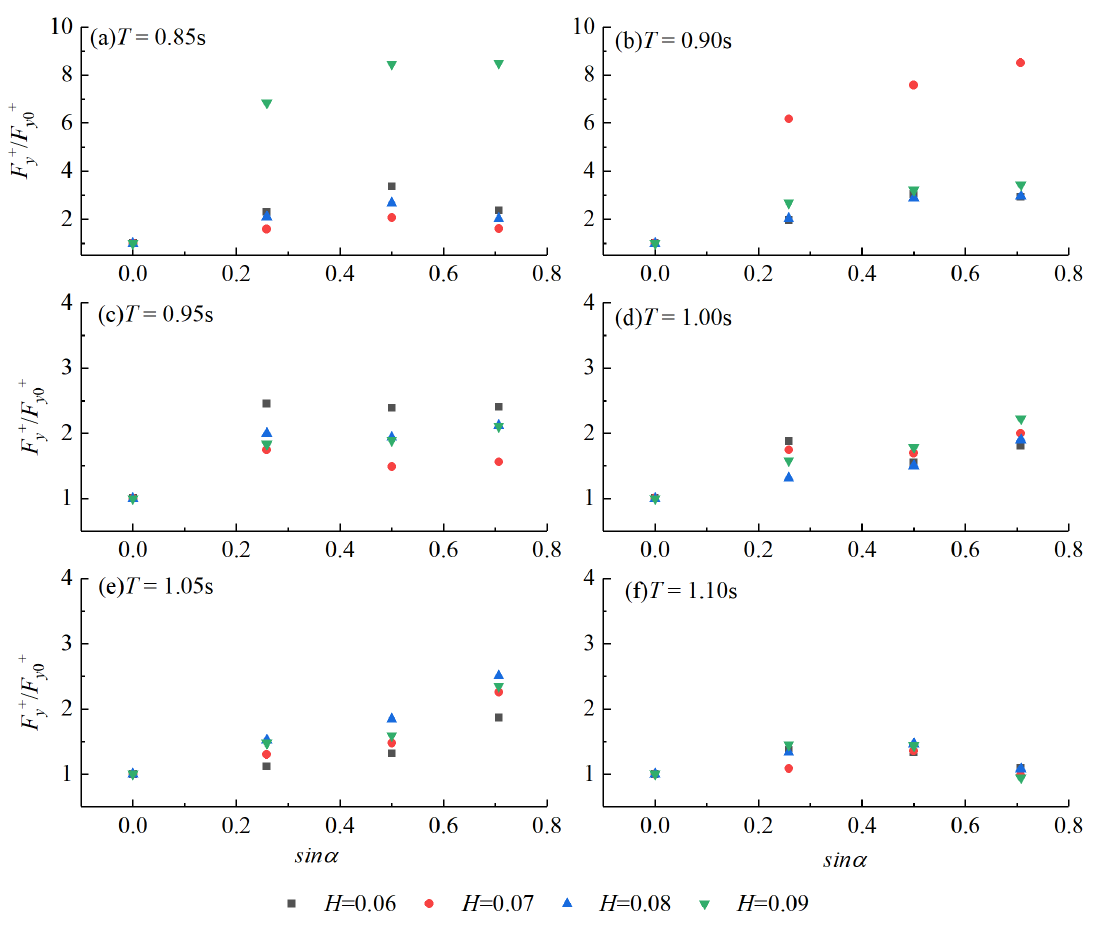
Figure 13. The wave directionality effect on the transversal positive peak force for the conditions of ( a ) T = 0.85 s, ( b ) T = 0.90 s, ( c ) T = 0.95 s, ( d ) T = 1.00 s, ( e ) T = 1.05 s, ( f ) T = 1.10 s.